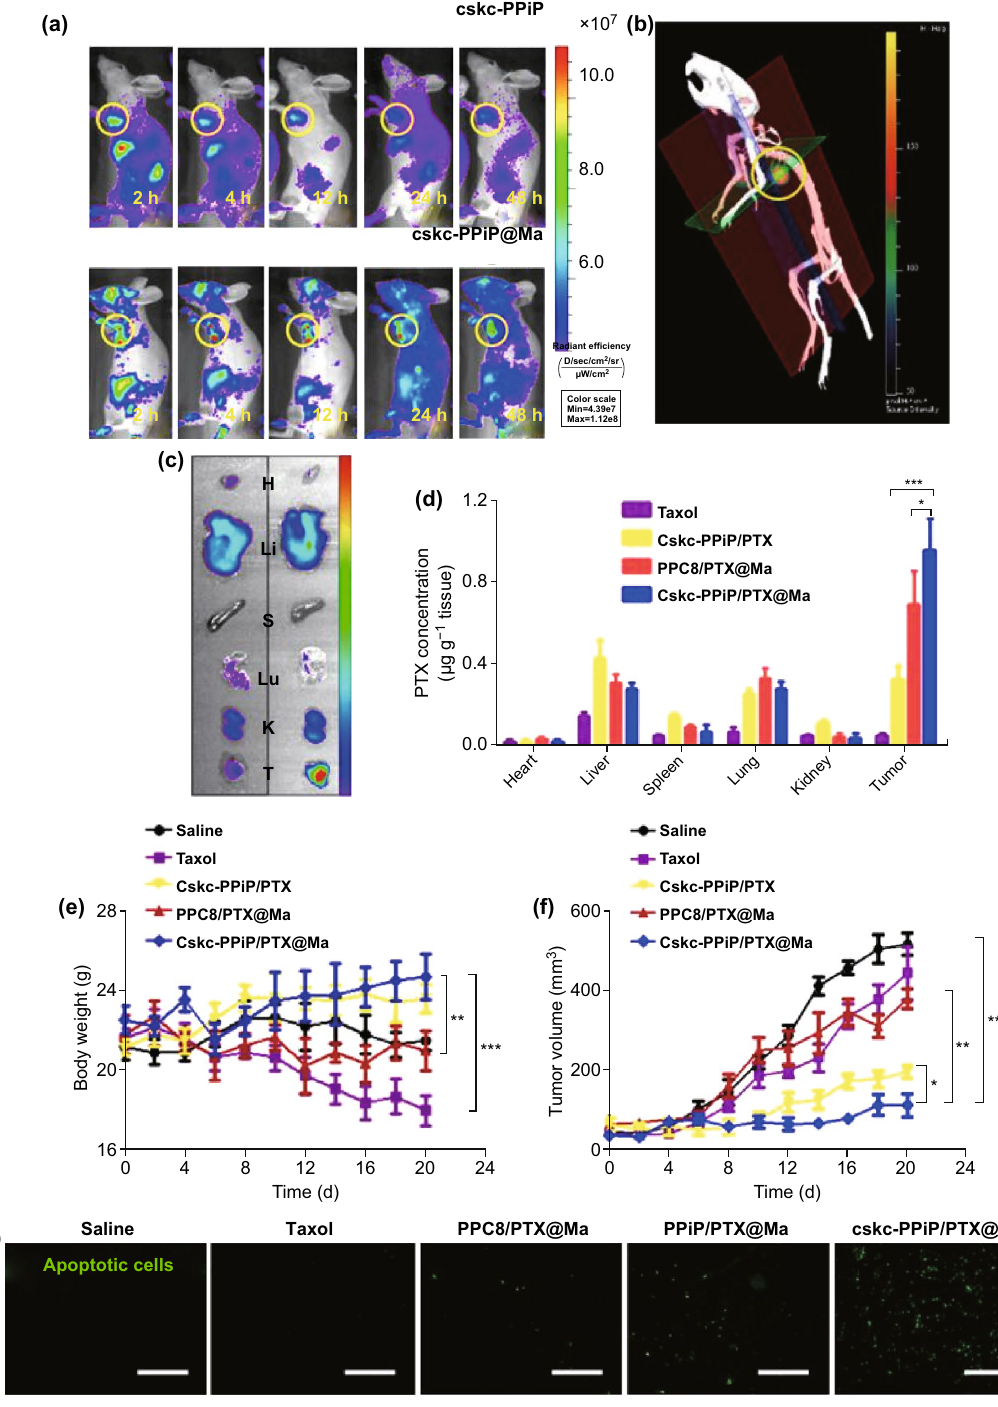
Fig. 9 a Mice were injected with either cskc‑PPiP or cskc‑PPiP@Ma NPs loaded with an IR probe for the indicated amount of time. b 3D reconstructed fluorescent image of signal in a mouse 48 h following cskc‑PPiP@Ma treatment. c Heart (H), liver (Li), spleen (S), lung (Lu), kid‑ ney (K), and tumor (T) tissues isolated from the mouse in b . d PTX levels in the organs of mice following treatment using PTX, cskc‑PPiP/PTX, PPC8/PTX@Ma, or cskc‑PPiP/PTX@Ma ( n = 4). e Body weight and f tumor volumes over 3 weeks in treated mice. g Tumor tissues from mice treated as indicated were assessed for apoptotic cells, shown in green. Scale bar = 100 μm. Adapted from Ref. [126] with